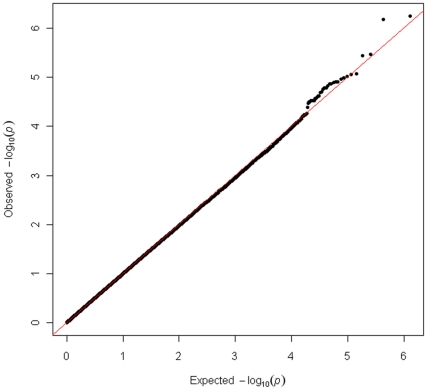
Quantile-quantile (Q-Q) plot of the observed GWAS p-values (−log10P).